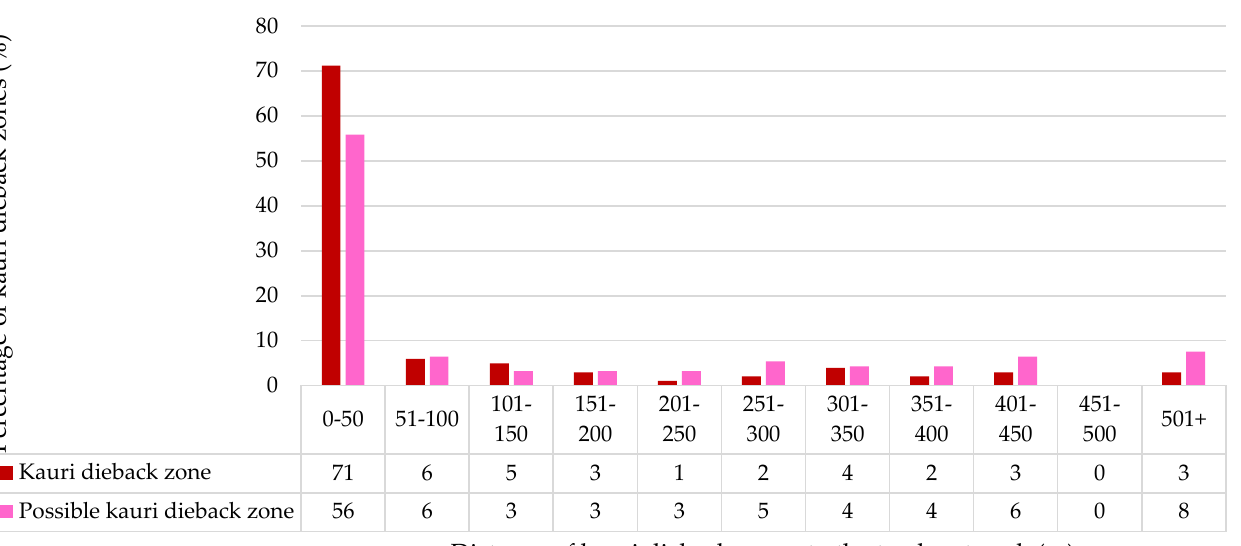
Figure 4. Percentage distribution of kauri dieback and possible kauri dieback zones to the track network within the WRRP.